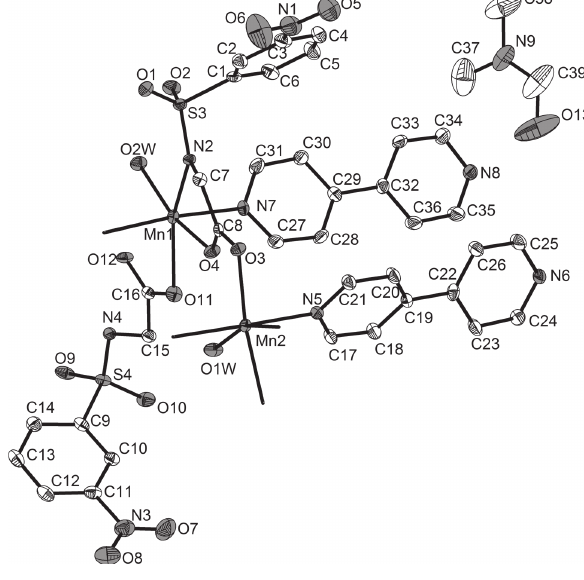
The asymmetric unit of the title crystal structure is shown in the figure. Tables 1 and 2 contain details on crystal structure